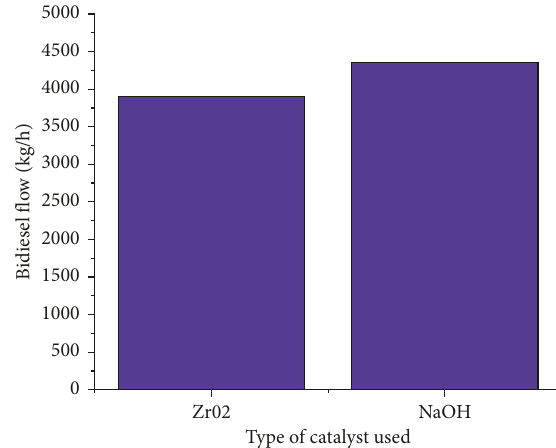
Figure 4: Biodiesel production concerning the type of catalyst used for the transesterification.